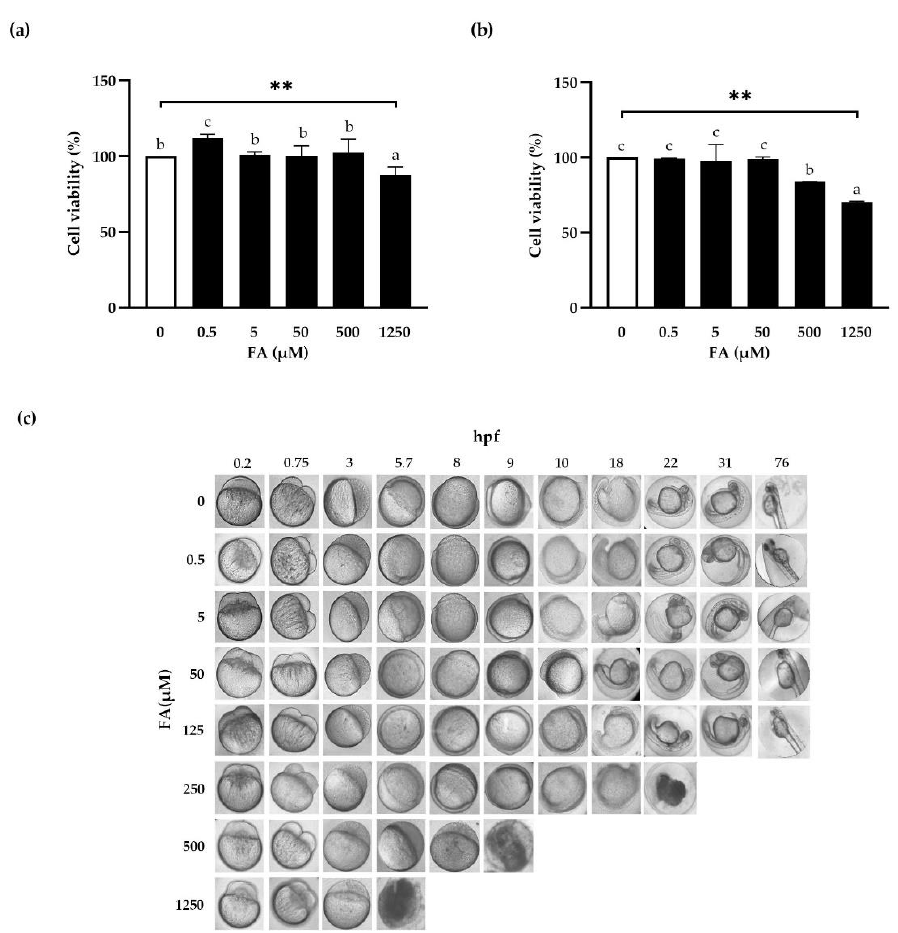
Figure 1. Effect of ferulic acid on cell viability. Caco-2 cells were treated with FA at the indicated concentrations for 24 h ( a ) or 48 h ( b ). Cell viabilities were measured using a WST assay. Results are presented as percentages of viable cells versus untreated cells. Zebrafish embryos were incubated with or without FA for 76 h per fertilization (hpf) ( c ). Pictures were taken at each time point. Data are the means ± SEM of three independent experiments. Duncan’s multiple range test was performed after one-way ANOVA to determine the significances of differences between FA groups. Significant differences are expressed as **: p < 0.01, and indicated by different letters. FA: ferulic acid; hpf: hours post fertilization.